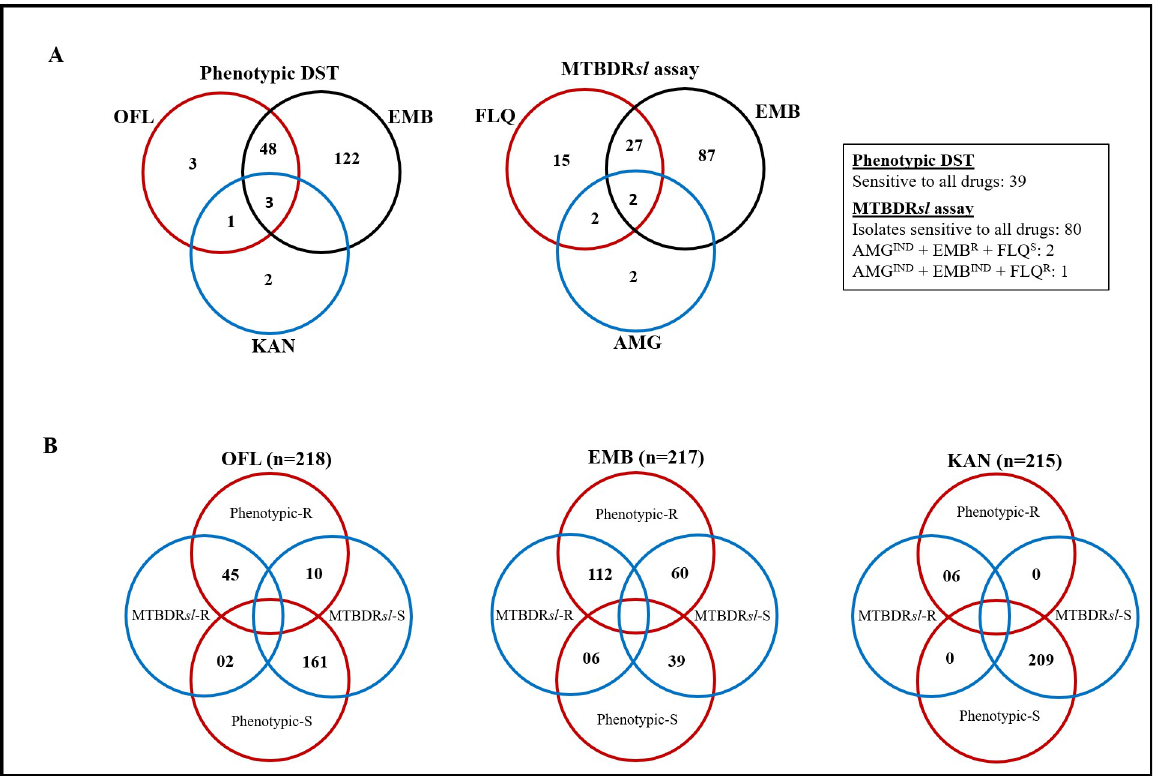
Fig 1. Venn diagram for comparison of the diagnostic performance between the phenotypic DST and MTBDR sl assay. A) Susceptibility results of OFL, EMB, and KAN determined by the phenotypic DST and MTBDR sl assay for 218 MDR-TB isolates. MTBDR sl assay yielded 3 indeterminate results to AMG, of which one had common indeterminate result to EMB also. B) Agreement between MTBDR sl assay and phenotypic DST for the detection of OFL, KAN and EMB susceptibility. OFL, ofloxacin; EMB, ethambutol; KAN, kanamycin; FLQ, fluoroquinolone; AMG, aminoglycoside; FLQ R , fluoroquinolone resistant; FLQ S , fluoro-quinolone sensitivie; EMB R , ethambutol resistant; AMG IND , aminoglycoside indeterminate; EMB IND , ethambutol indeterminate; Phenotypic-R, resistant by phenotypic DST; Phenotypic-S, sensitive by phenotypic DST; MTBDR sl -R, resistant by MTBDR sl assay; MTBDR sl -S, sensitive by MTBDR sl assay.